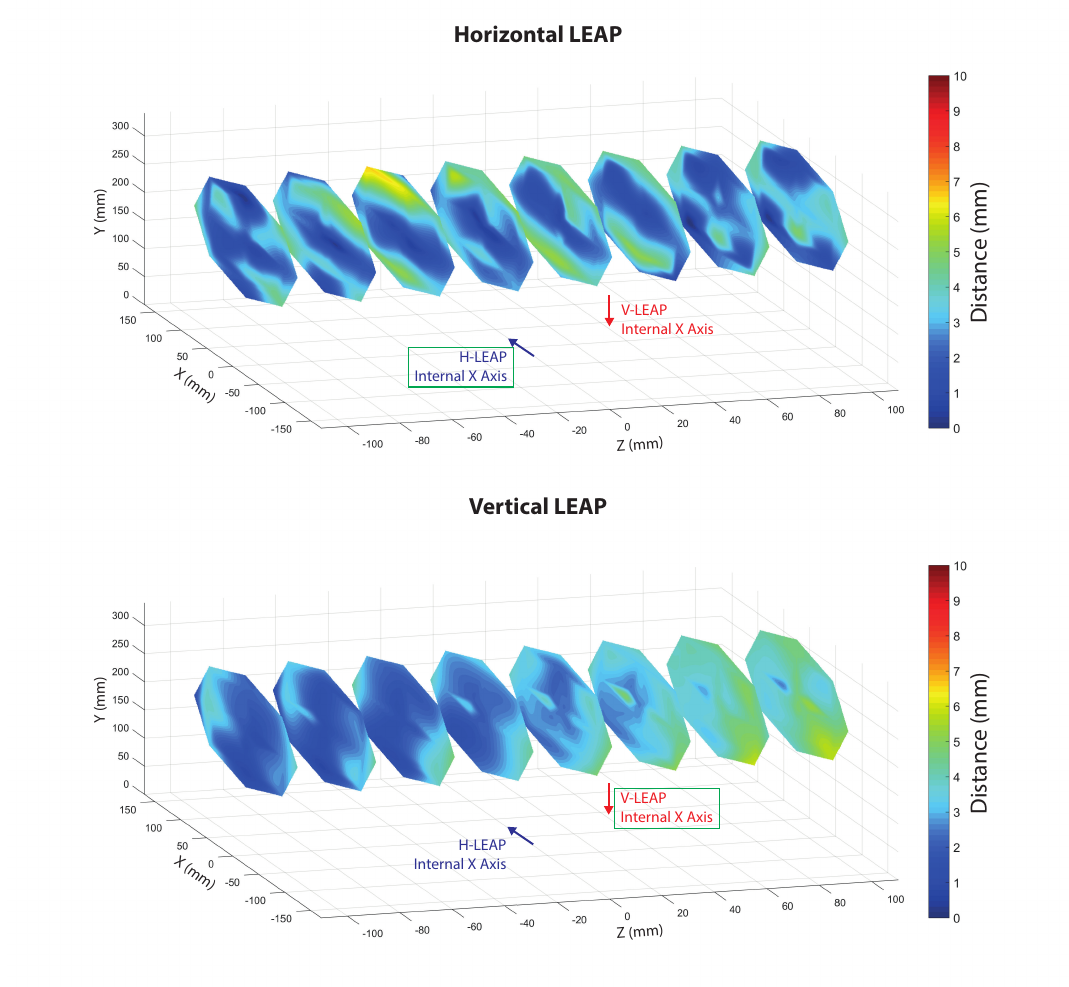
Figure 6. Global distances calculated from data of Figure 5 both for H-LEAP (upper panel) and for V-LEAP (lower